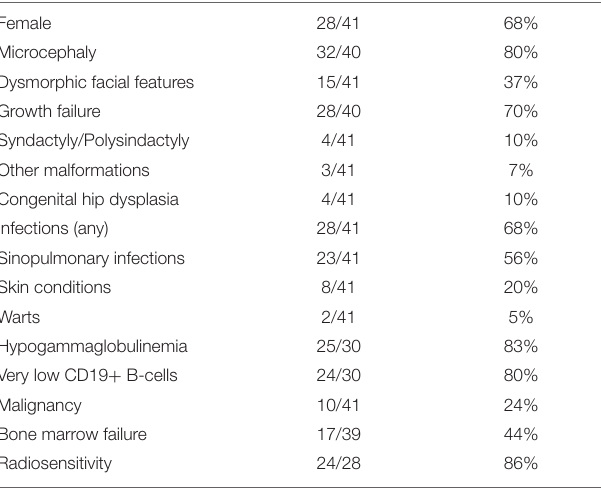
TABLE 4 | Prevalence of clinical and laboratory features found in 41 LIG4 deficiency